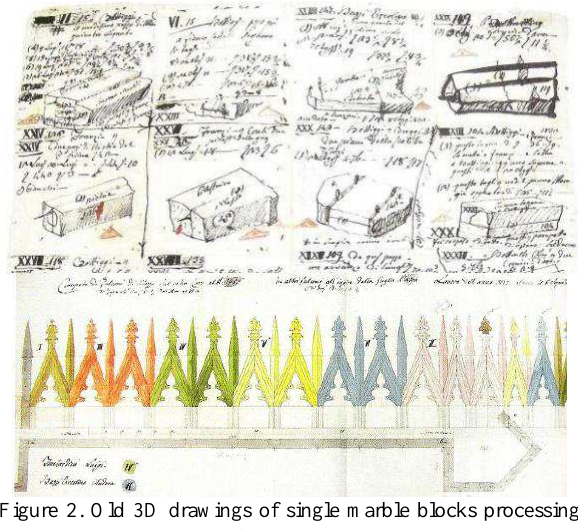
Figure 2. Old 3D drawings of single marble blocks processing with related info and description. 3D representations